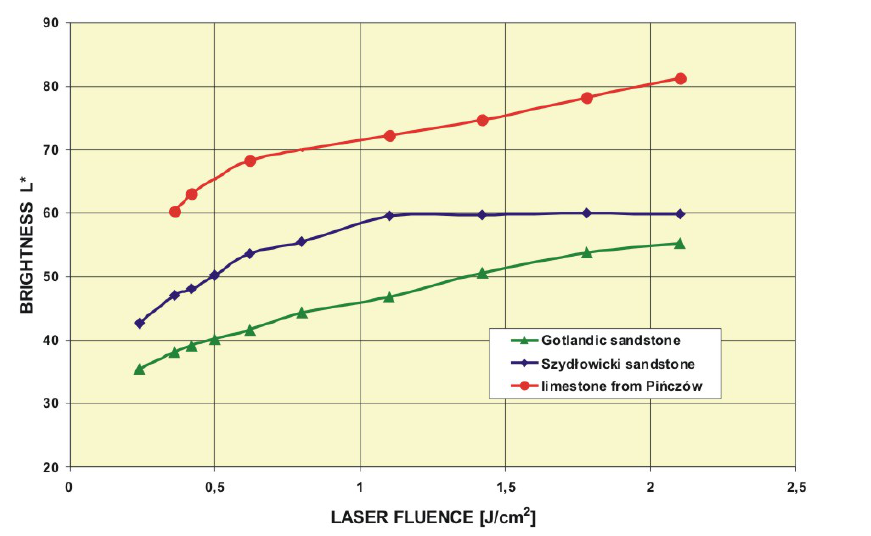
Figure 37. Dependence of the brightness L* on laser fluence in the laser cleaning tests of three objects presented in Table